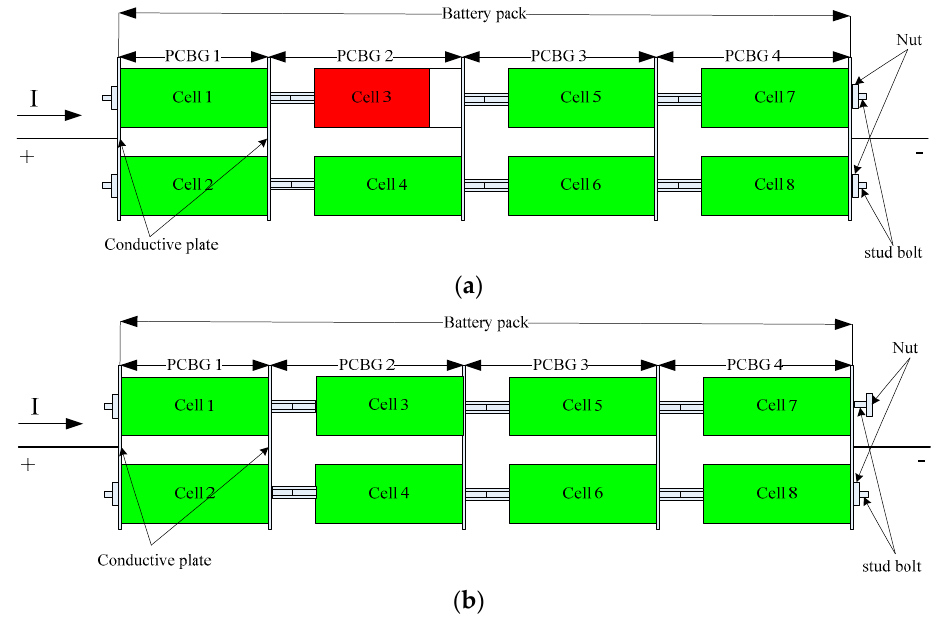
Figure 1. Two fault causes of capacity fade fault for PCBG: ( a ) cell aging inconsistency fault; ( b ) cell loose contacting fault.